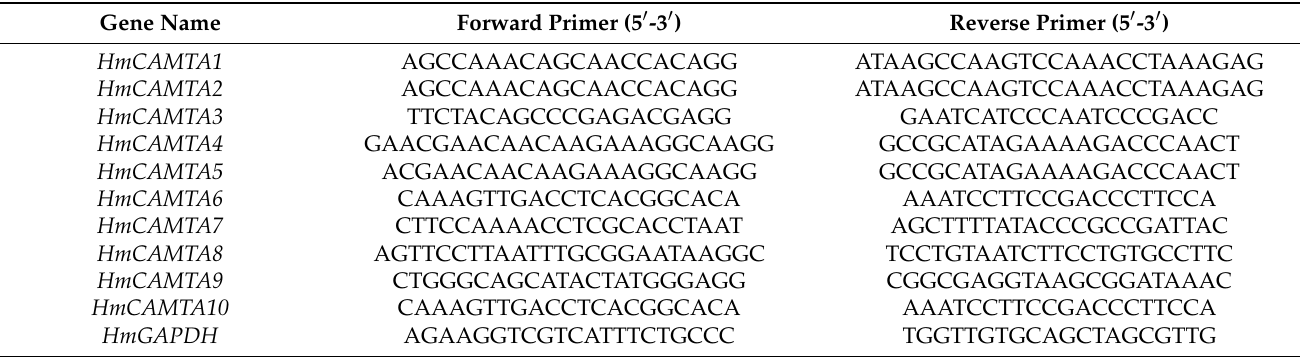
Table 3. qRT-PCR primers of HmCAMTA